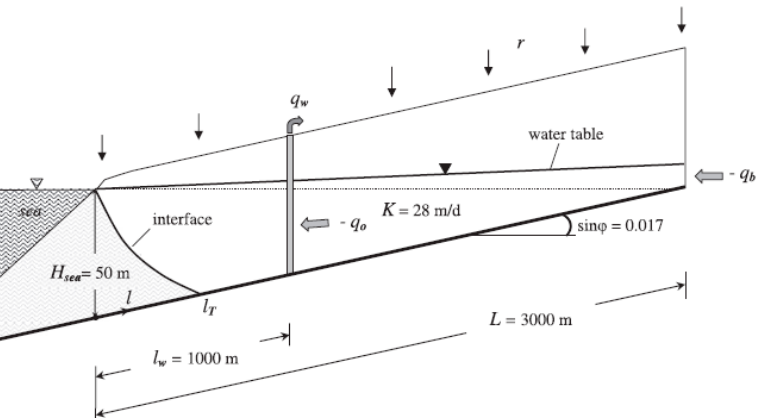
Figure A2. Profile concept of the Akrotiri aquifer, Zakaki area [52].